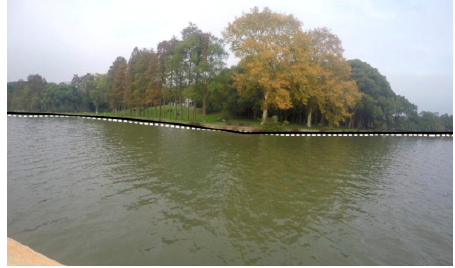
Figure 17. Comparisons between the WSL obtained by the method and the true value; the black line is the result of the method, and the white dot line is the true value obtained by hand.